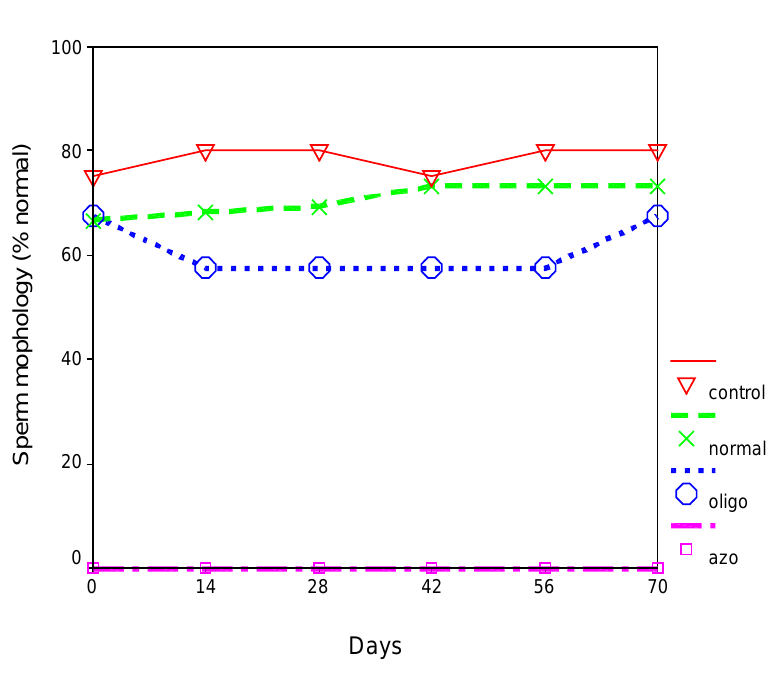
FIGURE 4. Effect of C. populnea aqueous extract on sperm